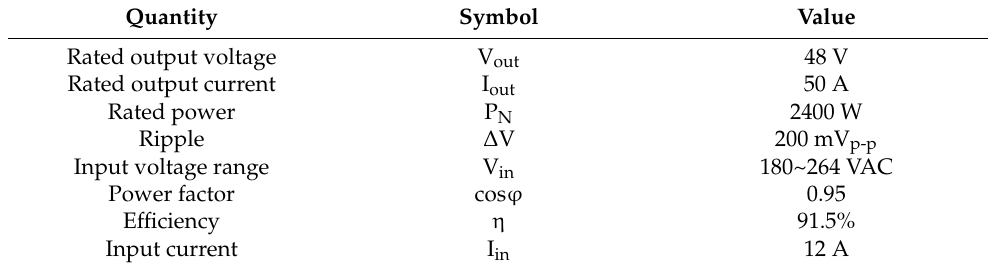
Table 4. DC power supply RSP-2400 technical